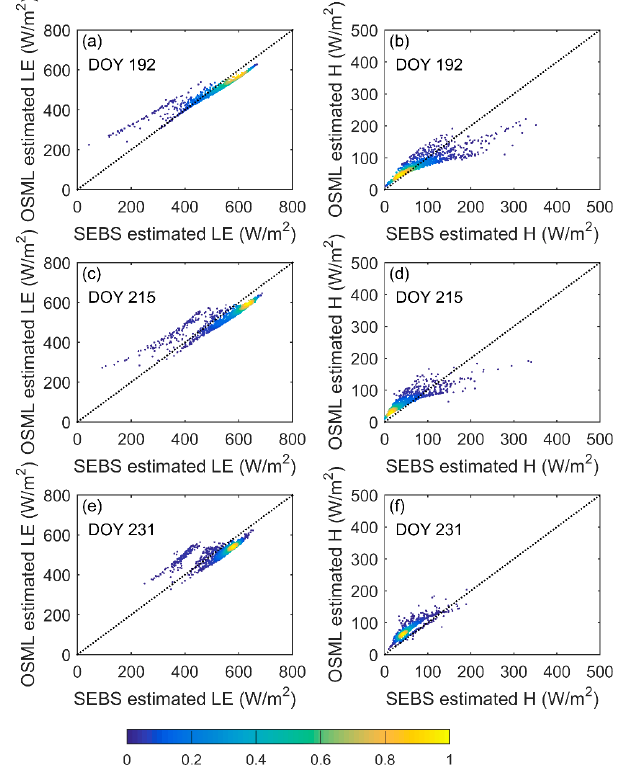
Figure 14. Comparison of OSML- and SEBS-derived LE on: DOY 192 ( a ); DOY 215 ( c ); and DOY 231 ( e ); and comparison of OSML- and SEBS-derived H on: DOY 192 ( b ); DOY 215 ( d ); and DOY 231 ( f ) (for the kernel experimental area in MUSOEXE, color shading indicates pixel density).